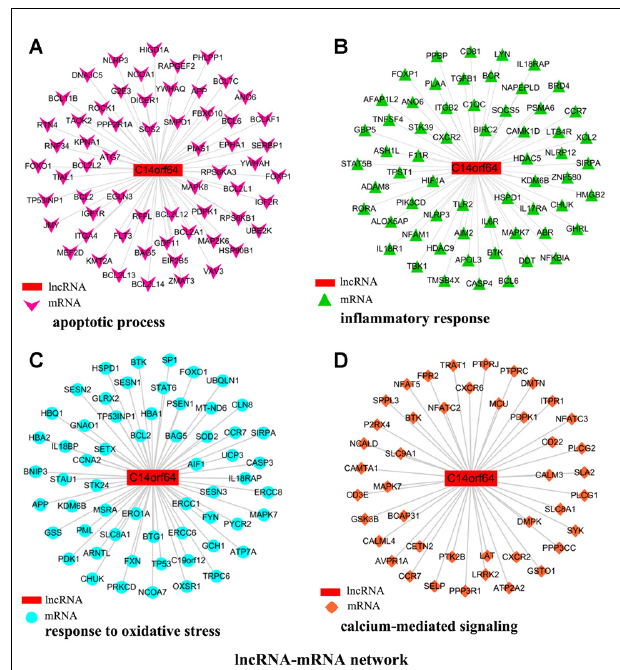
FIGURE 5 | Network of genes correlated with lncRNA-C14orf64. LncRNAs are shown as red rectangular nodes, and genes associated with apoptosis are shown as pink arrow nodes (A) ; genes associated with the inflammatory response are shown as green triangle nodes (B) ; genes associated with response to oxidative stress are shown as blue circular nodes (C) ; and genes associated with calcium-mediated signaling are shown as brown square nodes (D)